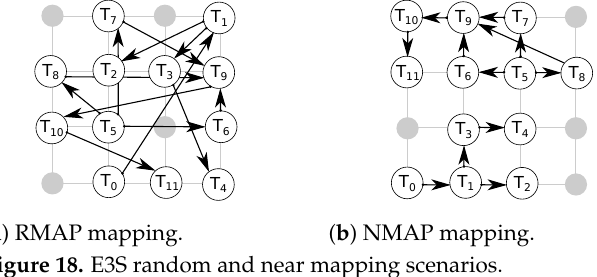
Figure 18. E3S random and near mapping